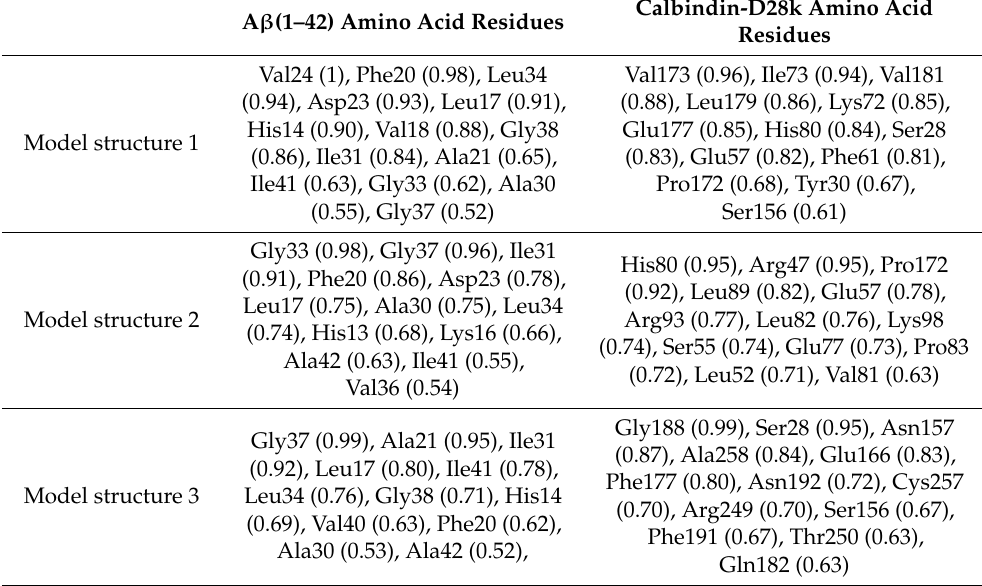
Table 2. List of strongly interacting amino acid residues of A β (1–42) and calbindin-D28k in the selected model structures 1, 2 and 3 yielded by docking simulations for the 1:1 A β (1–42):calbindin- D28k complex. The amino acid residues of both A β (1–42) and calbindin-D28k are listed from high to lower values of the parameter BSA/ASA (values in parenthesis) obtained from the interface analysis with PDBePISA software. Only amino acid residues with BSA/ASA values ≥ 0.5 for A β (1–42) and ≥ 0.6 for calbindin-D28k are